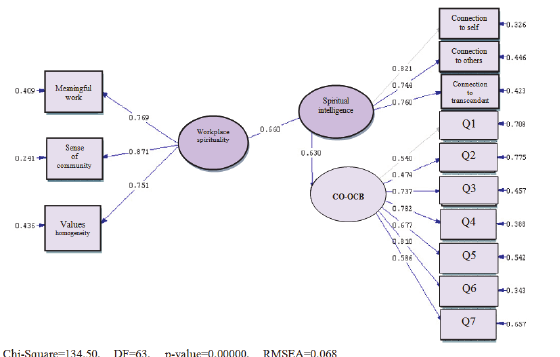
Fig. 7. The estimation model of the impact by “spirituality Fig. 8. General model significant figures